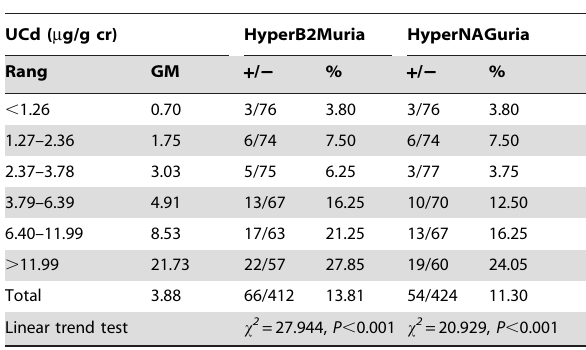
Table 4. Prevalence of hyperB2Muria and hyperNAGuria corresponding to UCd intervals grouped by the 16.67 th (1.26), 33.33 th (2.36), 50.00 th (3.78), 66.67 th (6.39), and 83.33 th (11.99) percentiles among all subjects a .